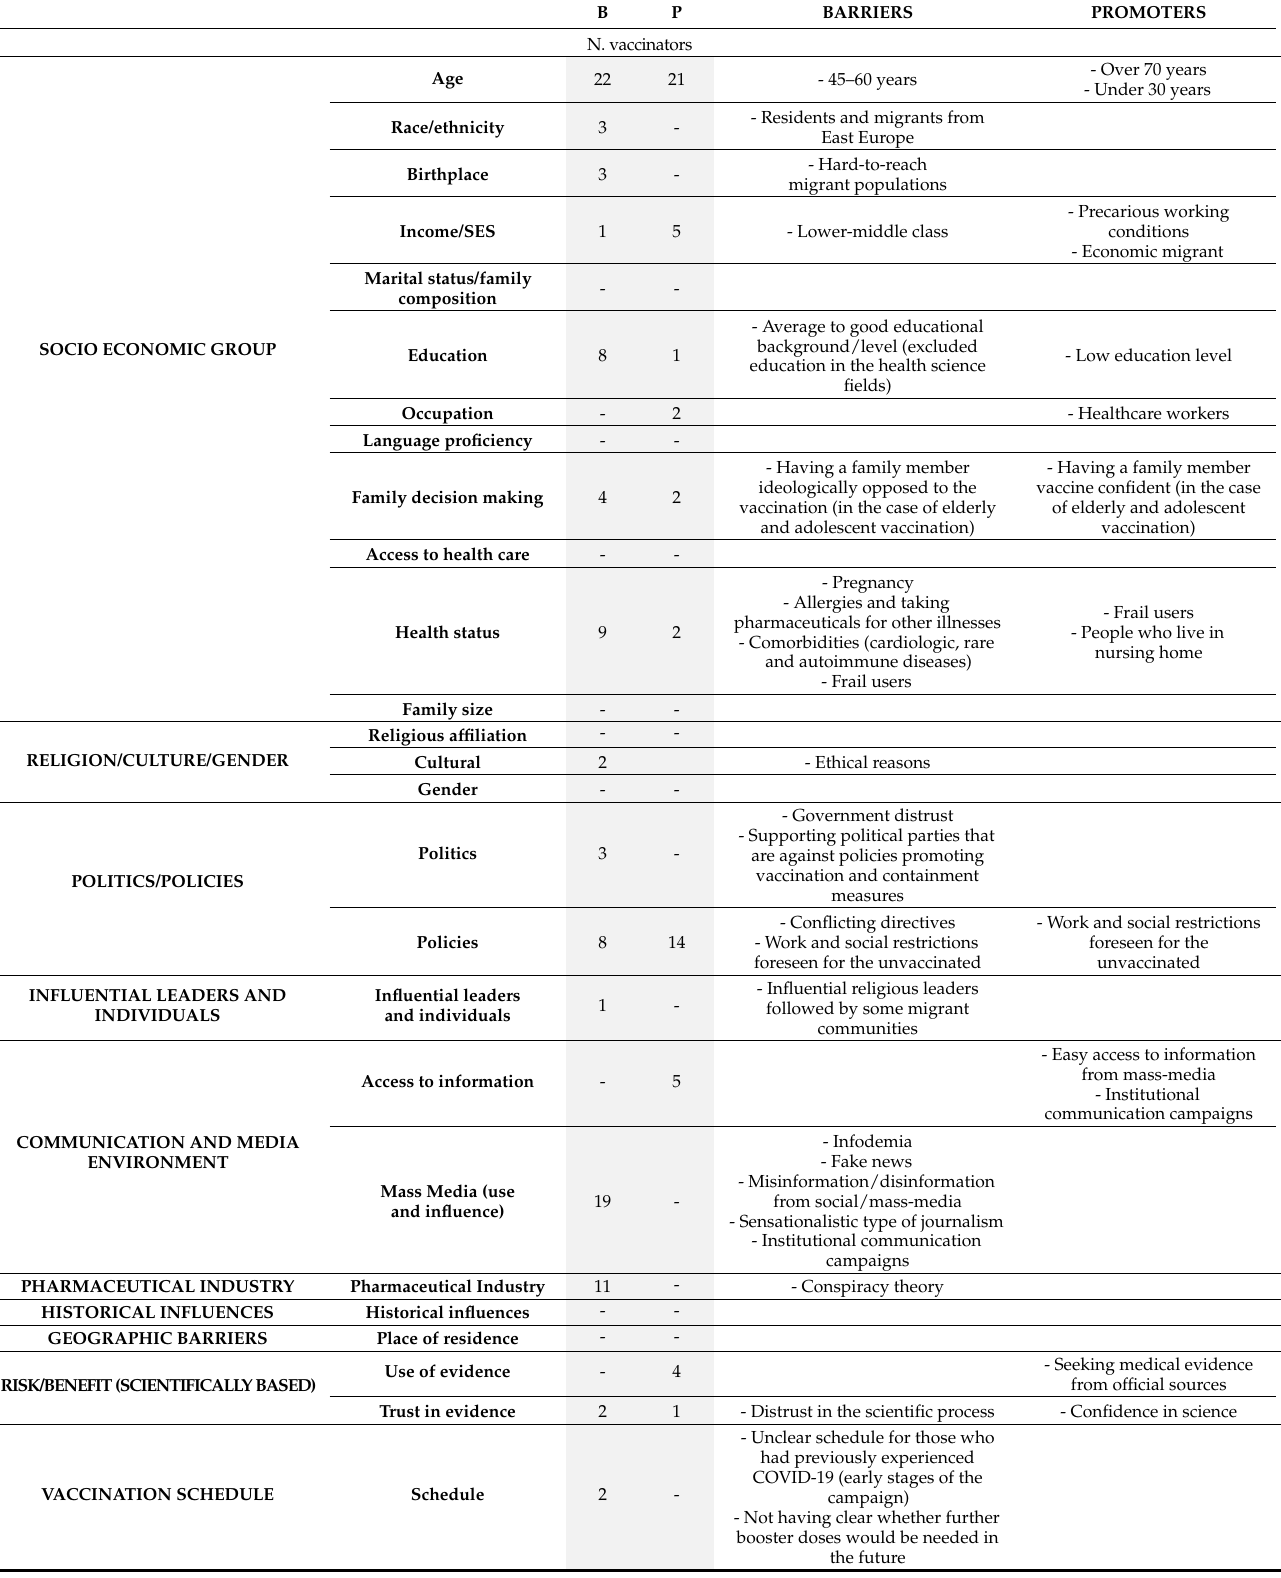
Table 3. Factors identified in the interviews as either barriers (B) to or promoters (P) of COVID-19 vaccination and mapped onto the SAGE Working Group model of determinants of vaccine hesitancy.